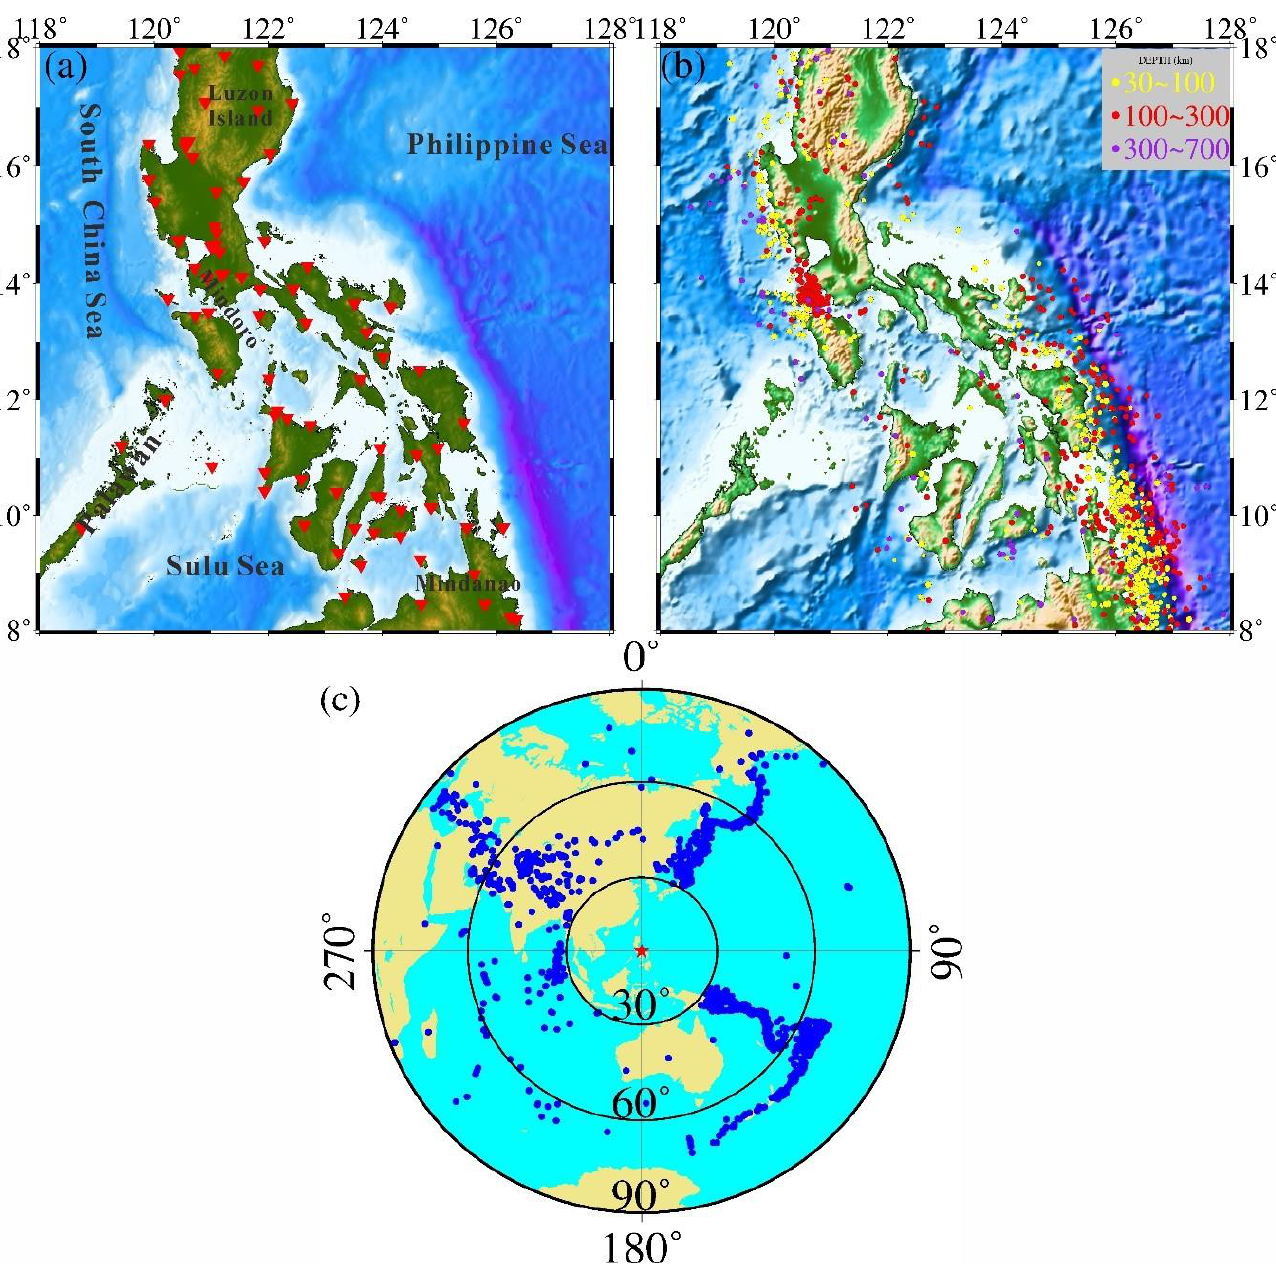
Figure 2. ( a ) Locations of receivers used in this work. The red invert triangles indicate receivers; ( b ) Locations of teleseismic events picked for tomography inversion. The red star denotes the center point of the study area. The blue dots represent teleseismic events; ( c ) Local seismic events occurred in the study area in recent 10 years. Different colors indicate different depths of seismic events.